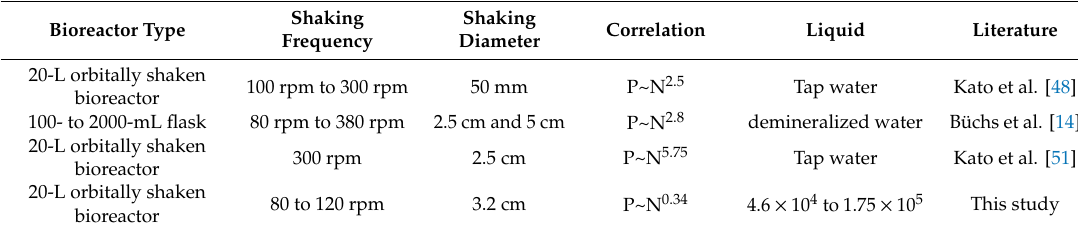
Table 3. Correlation between power consumption and shaking frequency.